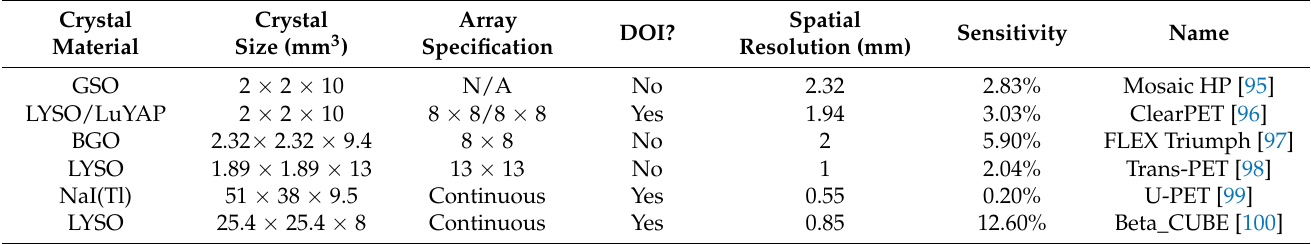
Table 3. Scintillation crystals used in SAP and their properties.